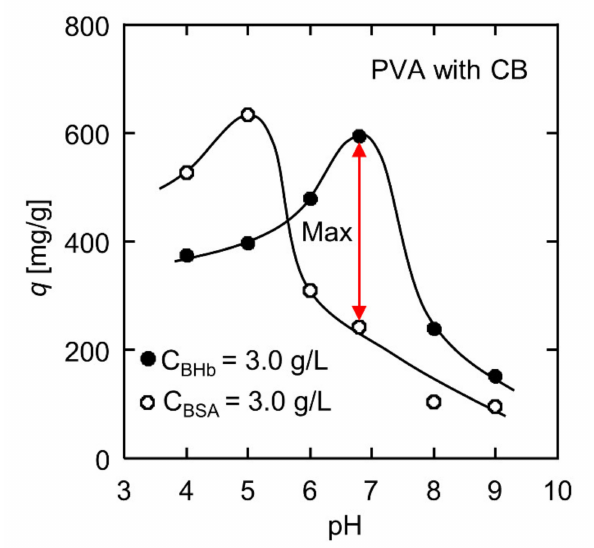
Figure 5. Effect of pH on BHb and BSA adsorption